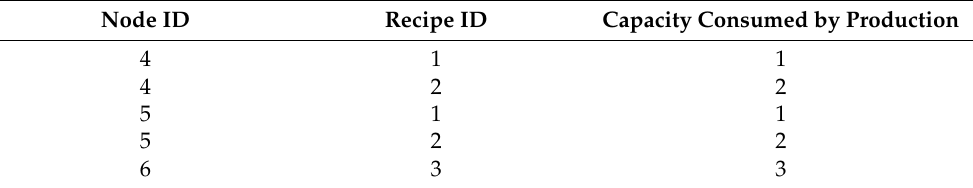
Table 4. Product-dependent unit cost in all intermediate nodes per time period.